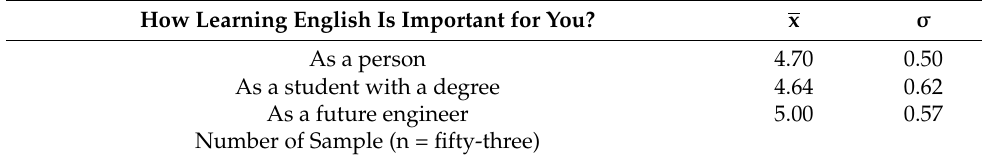
Table 2. The Significance of Learning English.